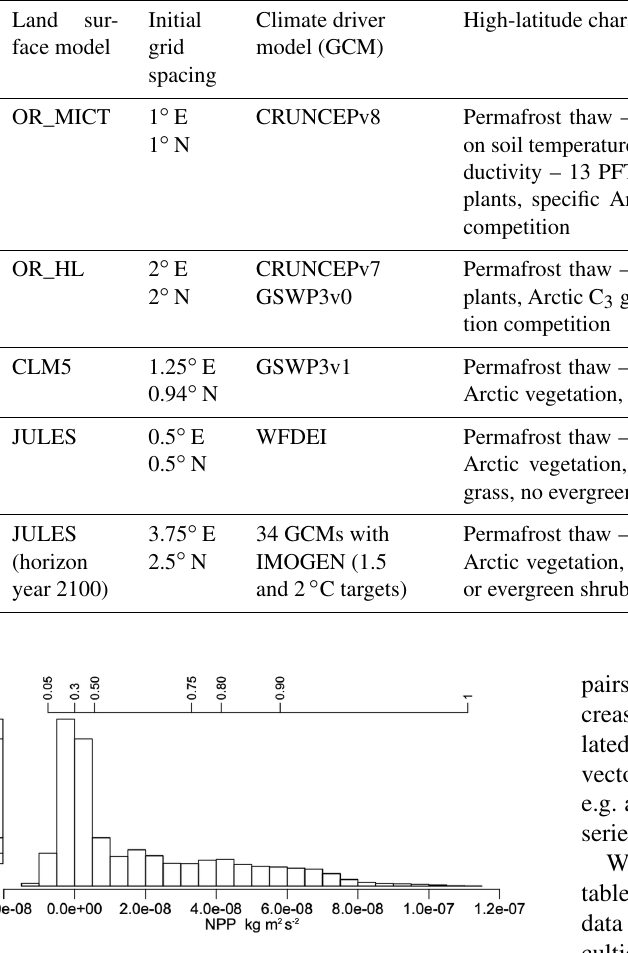
Figure 1. Histogram of NPP values (kgm − 2 s − 1 ) in the three-way table for the four LSMs for the period 1998–2013 and the selected CLINF region; the top axis indicates cumulative